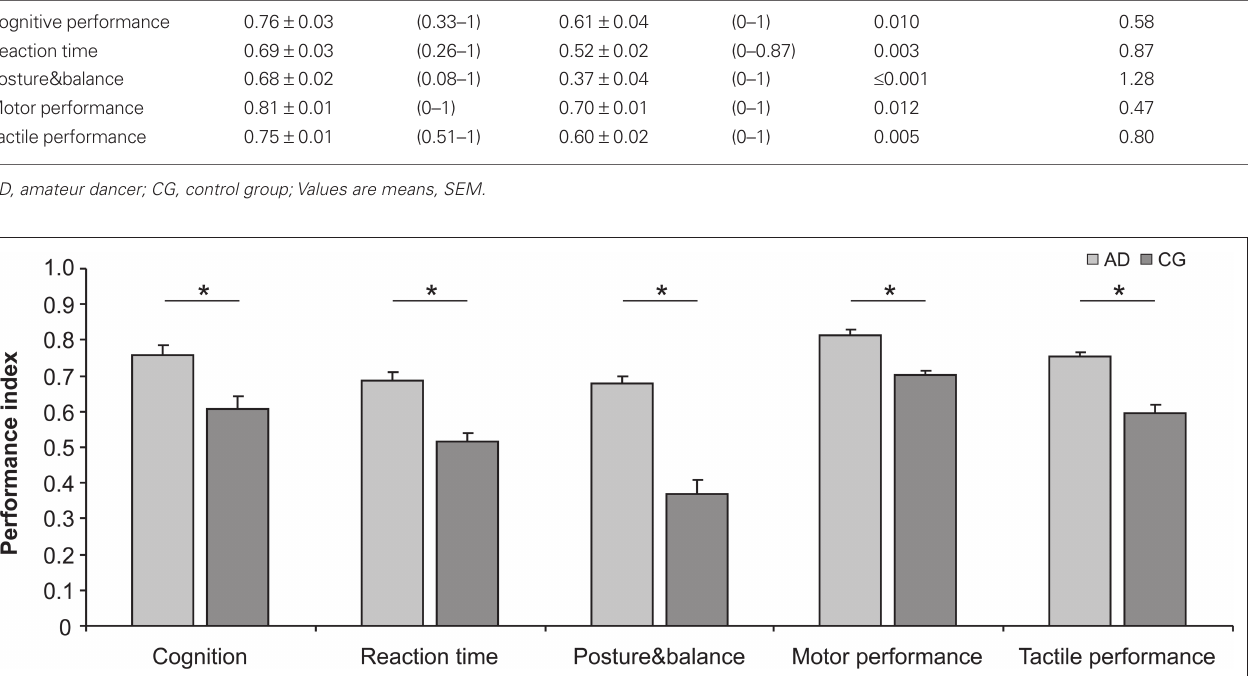
“Posture&balance” ( p < 0.001) comprises Romberg test , Standing-turn test and Up&go test . “Motor performance” ( p = 0.012) comprises Steadiness, Aiming, Pin plugging and Tapping . “Tactile performance” ( p = 0.005) comprises touch thresholds and 2-point-discrimination thresholds. Vertical bars show standard error of the mean. Asterisks mark significant differences between the two